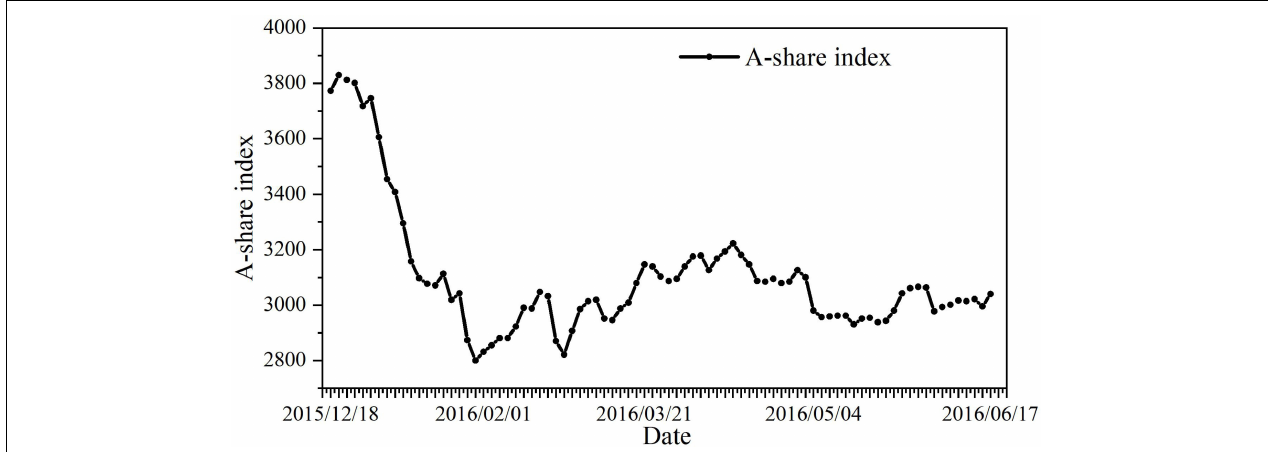
FIGURE 6 | Trend chart of the A-share index during the suspension period of Vanke. Data source: Trend chart of the A-share index during the suspension period of Vanke.